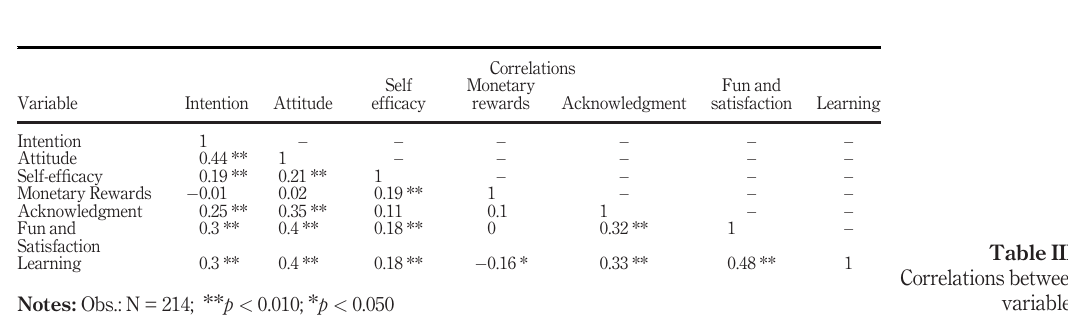
Figure 1. Variables in fl